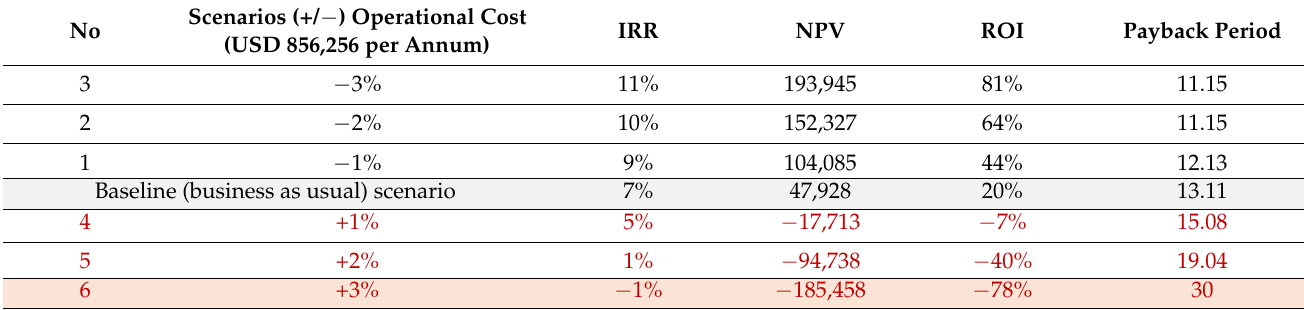
Table 7. Cost adjustment (sensitivity analysis) scenarios for the